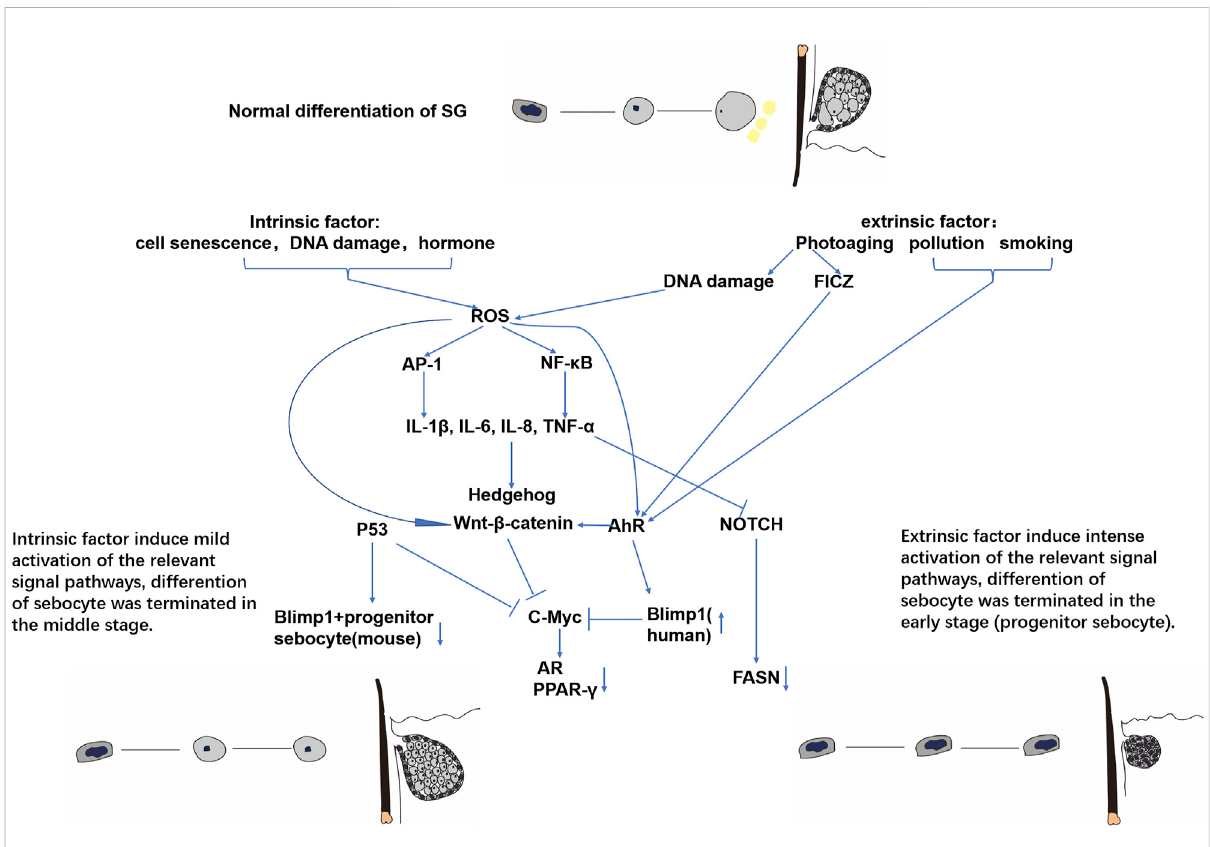
FIGURE 4 Possible molecular mechanisms of intrinsic and extrinsic SG